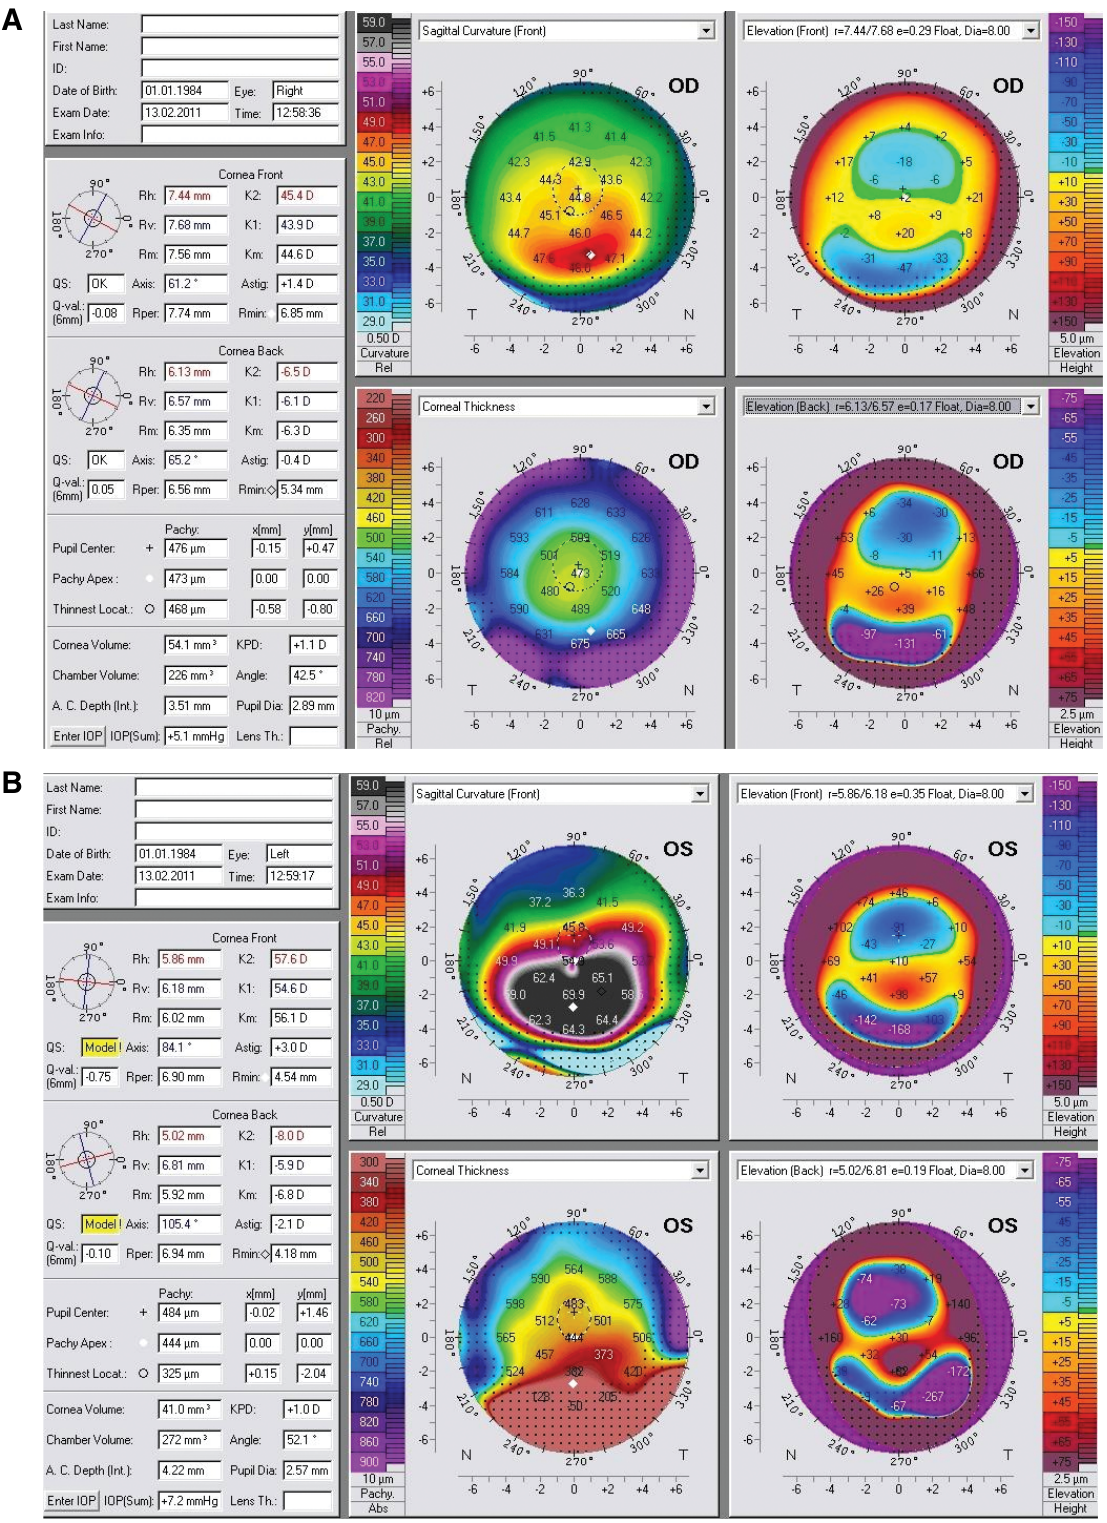
Figure 5a and b. A case with PMD in one eye and PLK in the other. ( A ): The right eye is PLK; notice the absence of the bell sign. ( B ): The left eye is PMD; notice the presence of this sign.